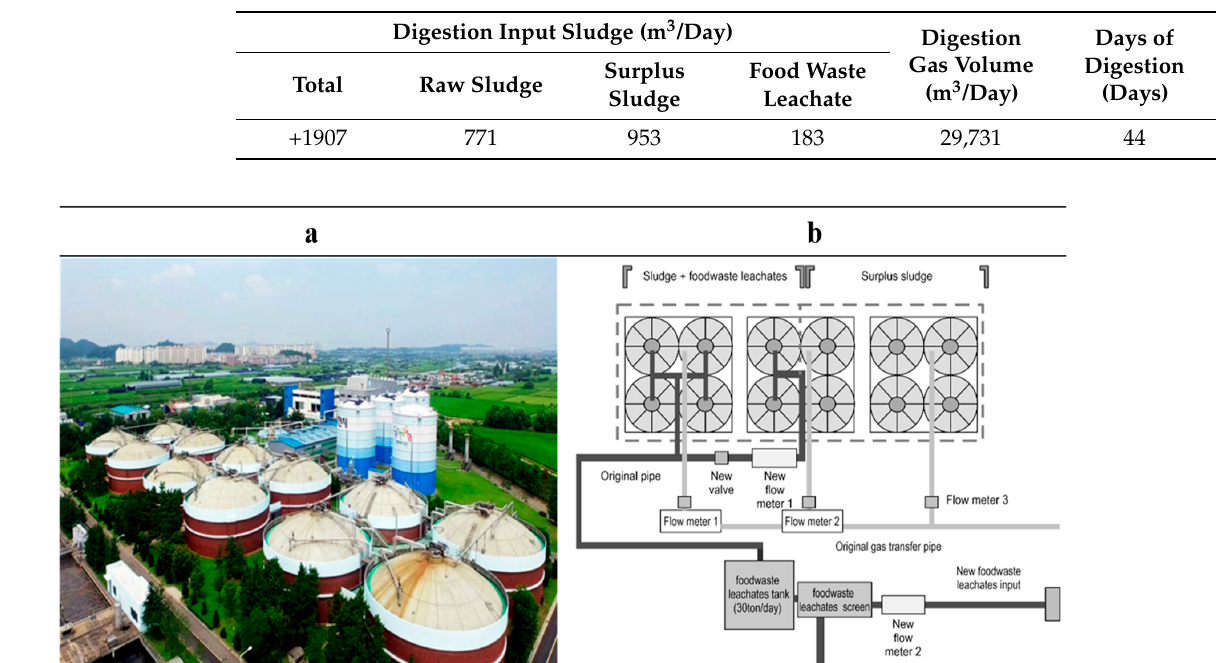
Table 1. Anaerobic digester capacity of the wastewater treatment plant.